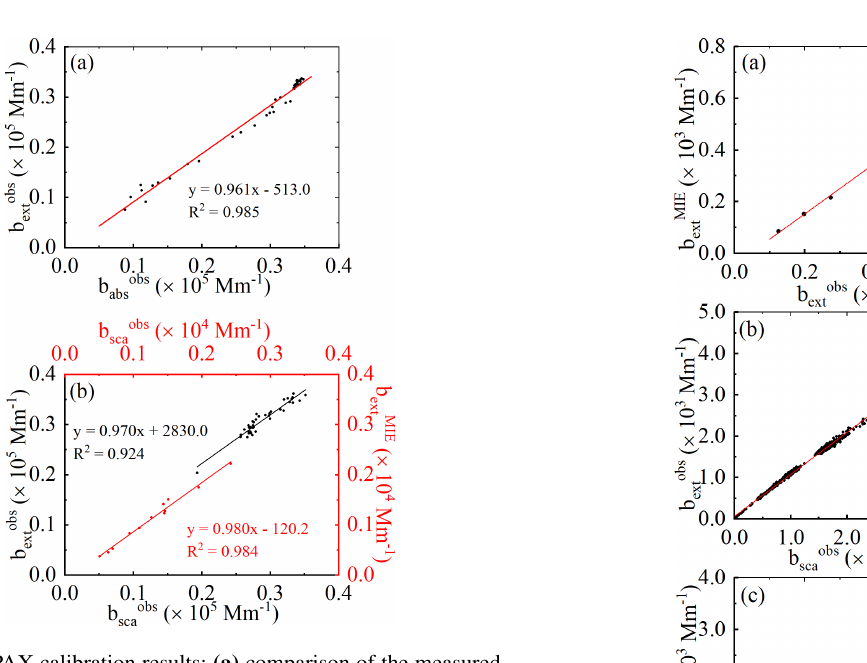
Figure 2. PAX calibration results: (a) comparison of the measured extinction and absorption coefficient; (b) comparison of the mea- sured and MIE model calculated extinction coefficient with the measured scattering coefficient.